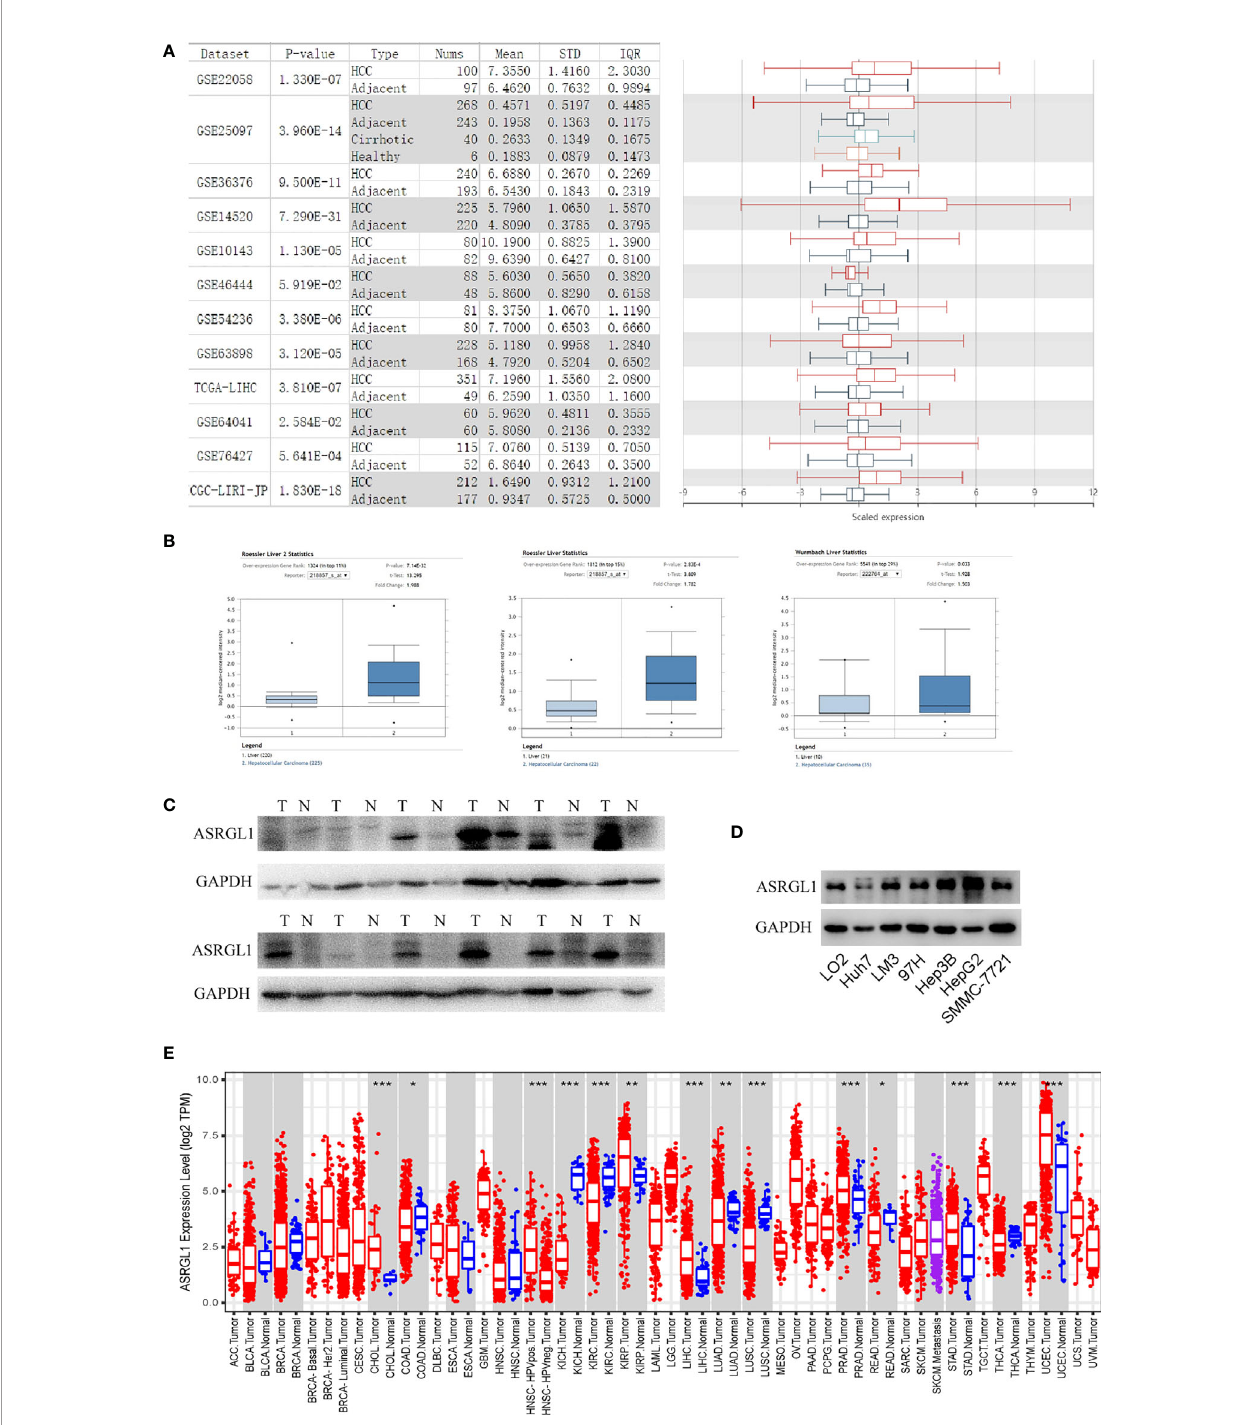
FIGURE 1 | The expression of ASRGL1 in HCC. (A) The graph and the corresponding plot show the mRNA expression of ASRGL1 in tumor tissues and adjacent healthy tissues, according to the t -test in HCCDB. (B) Box plot showing ASRGL1 mRNA expression in the Roessler Liver, Roessler Liver 2, and Wurmbach Liver datasets, respectively. (C, D) Western blot showing that ASRGL1 was upregulated in HCC tissues and HCC cell lines compared with adjacent healthy tissues and LO2 cells. (E) Expression of ASRGL1 in different tumor types from the TCGA database in TIMER. *p < 0.05, **P < 0.01, ***P < 0.001. (ACC, BLCA, CESC, CHOL, COAD, DLBC, ESCA, GBM, HNSC, KICH, KIRC, KIRP, LAML, LGG, LIHC, LUAD, LUSC, MESO, OV, PAAD, PCPG, PRAD, READ, SARC, SKCM, SKCM, TGCT, HCA, THYM, UCEC, UCS,